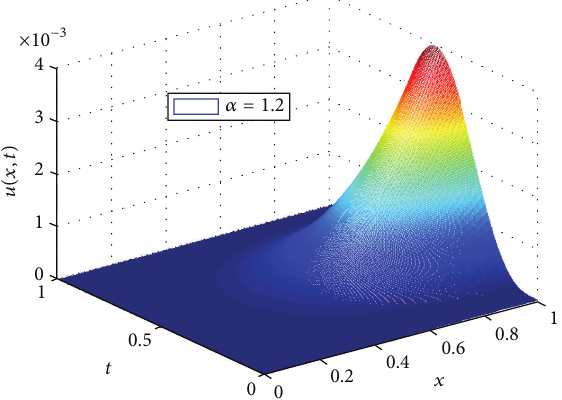
Figure4:Theanalyticalsolutionsurfacewhen 𝛼 = 1.2 inExample 3.